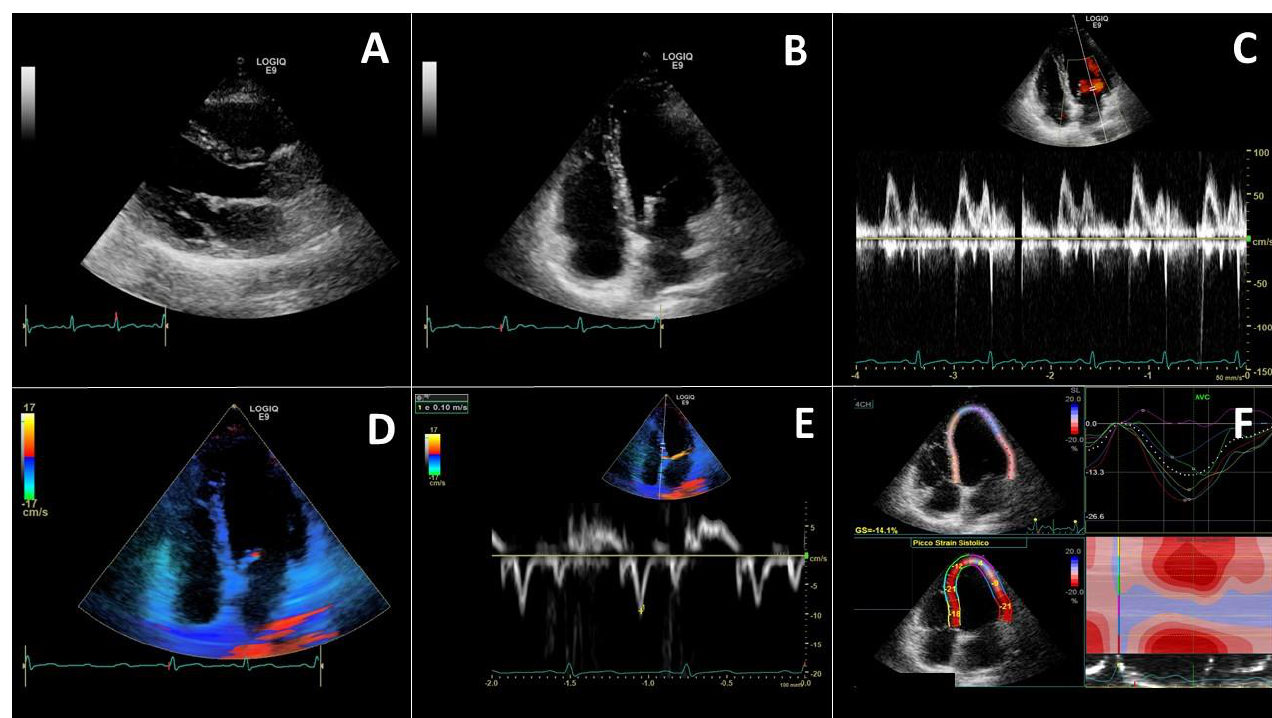
Figure 3. Left heart evaluation needs a complete echocardiography evaluating parasternal long-axis ( A ) and apical 4 chamber ( B ) views. Using pulsed wave Doppler trans-mitral flow is evaluated ( C ). The apical 4 chamber view allows to perform tissue Doppler imaging analysis ( D ), able to make a doppler spectral analysis of the myocardial contraction velocity wave ( E ). A complete evaluation also includes the Speckle tracking evaluation to obtain the longitudinal strain ( F ). In particular the shown image was obtained in a 28-year old girl with a COVID-19 myocarditis.